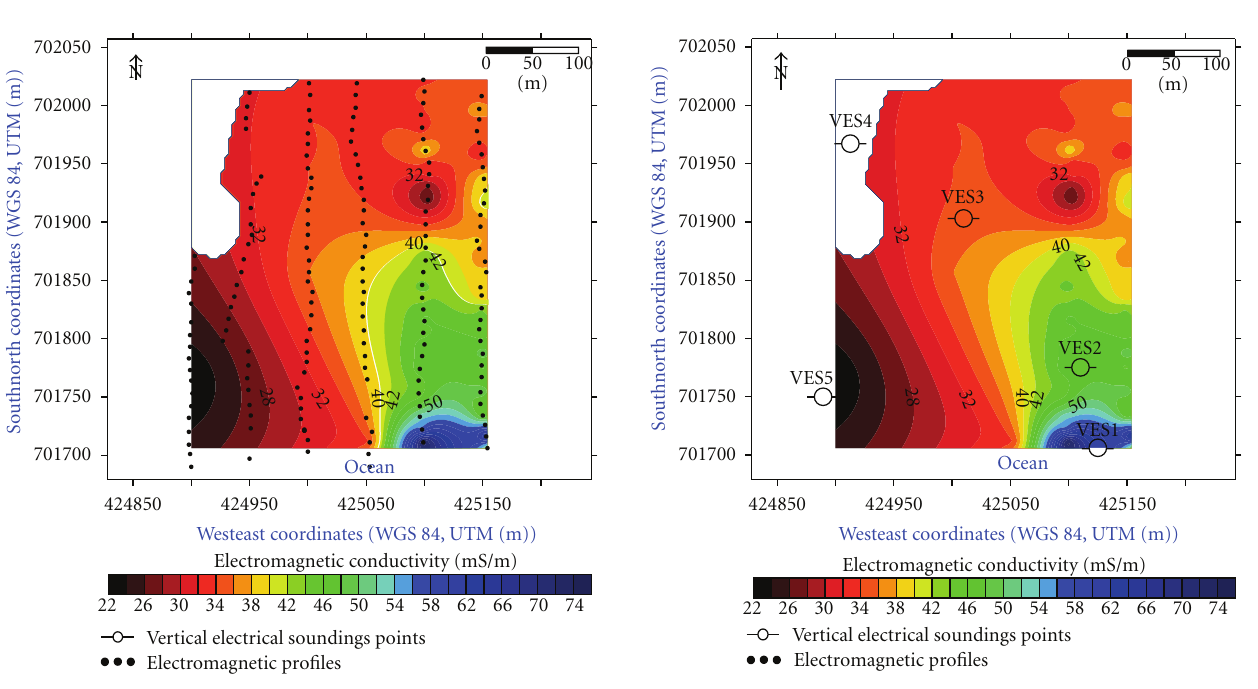
Figure 7: Chart of electromagnetic conductivity. Figure 8: VES localization on chart of electromagnetic conductiv-